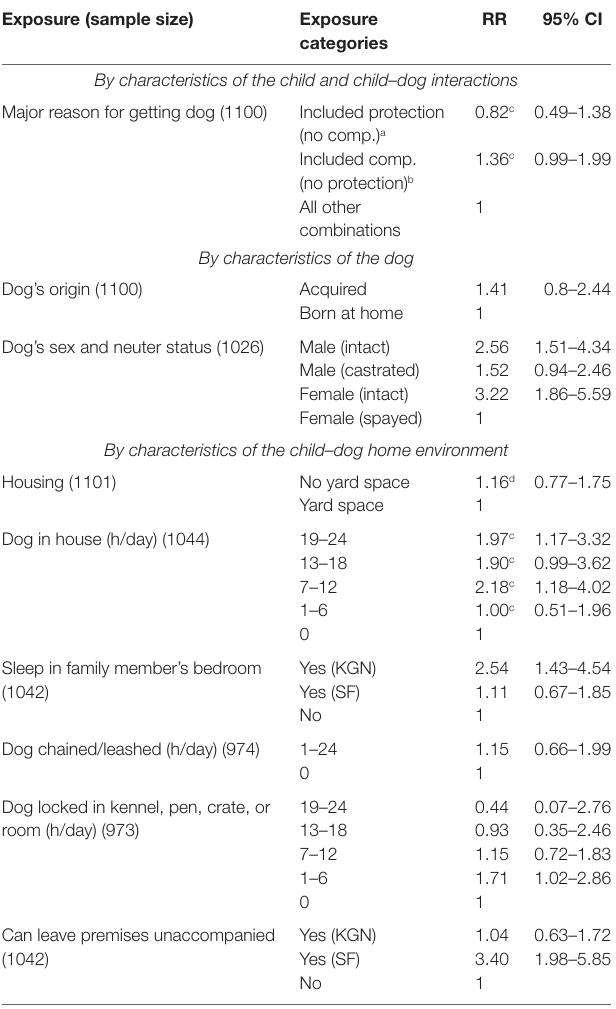
TaBle 5 | Adjusted relative risks (RR) and 95% confidence intervals for associations between selected variables and dog bites in general, Kingston (KGN), Jamaica, and San Francisco (SF) (Adapted from Messam et al., 2008)